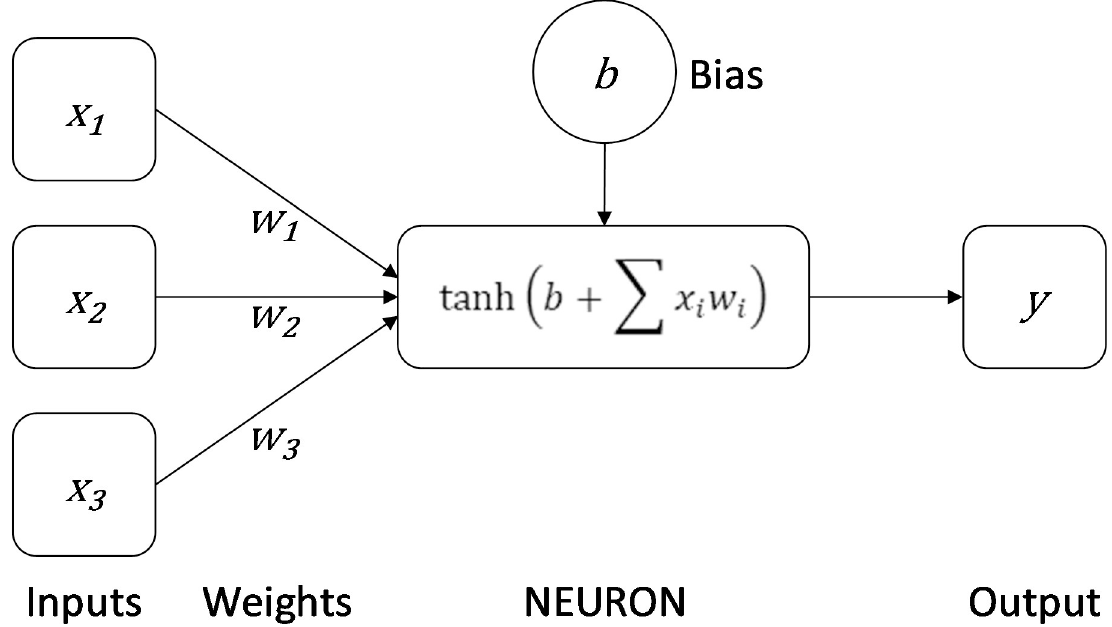
Fig 1. The structure of a single artificial neuron. Inputs (in this case presences or absences of technologies in an assemblage) are multiplied by ‘synapse’ weights; these products are then summed and added to the bias of the neuron. Finally, an activation function (in this case the hyperbolic tangent) is applied to this sum to determine the strength at which the neuron will ‘fire’ (i.e. the activation function determines the value that will be propagated on to the neuron(s) in the next layer of the network).